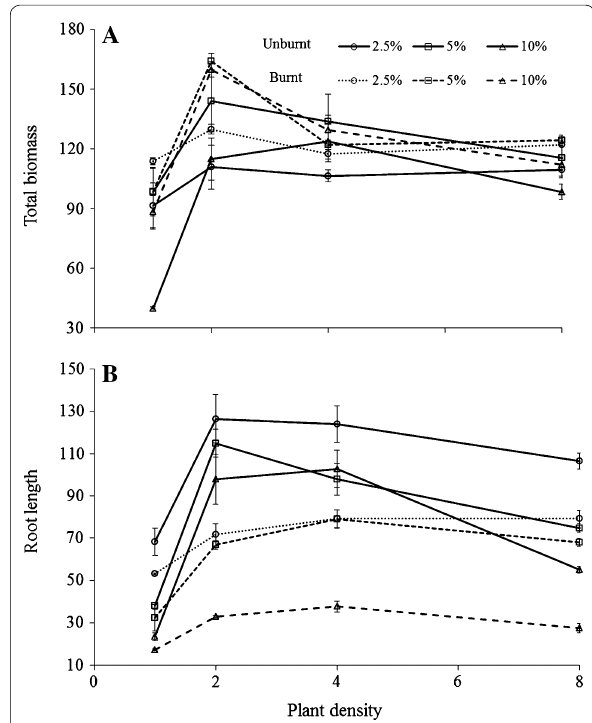
Fig. 2 Relationship of A total biomass and B root length with seedling densities of Lactuca sativa grown at different concentrations of Phragmites australis litter (unburnt versus burnt) extracts. Values (weight per plant and length per plant) are means as % of control treatments at each density standard errors ( n 3 ) ± =